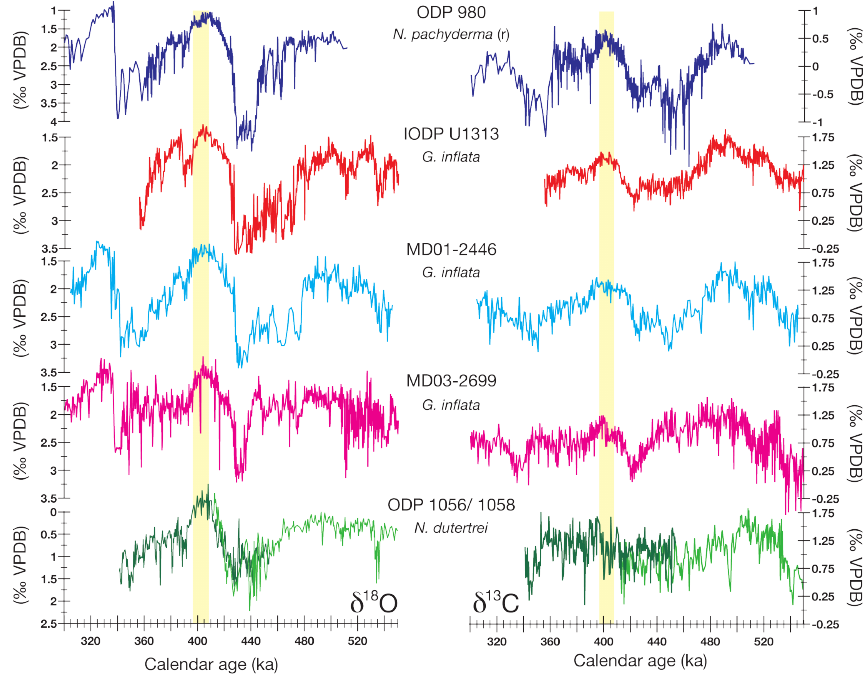
Fig. 7. North Atlantic planktic foraminifer stable isotope records with δ 18 O records on the left and δ 13 C records on the right. Sites are arranged from North to South: ODP Site 980 (dark blue), IODP Site U1313 (red), MD01-2446 (light blue), MD03-2699 (magenta), and ODP Sites 1056 (dark green) and 1058 (light green) combined. Yellow bars highlight the period of the MIS 11c sea level